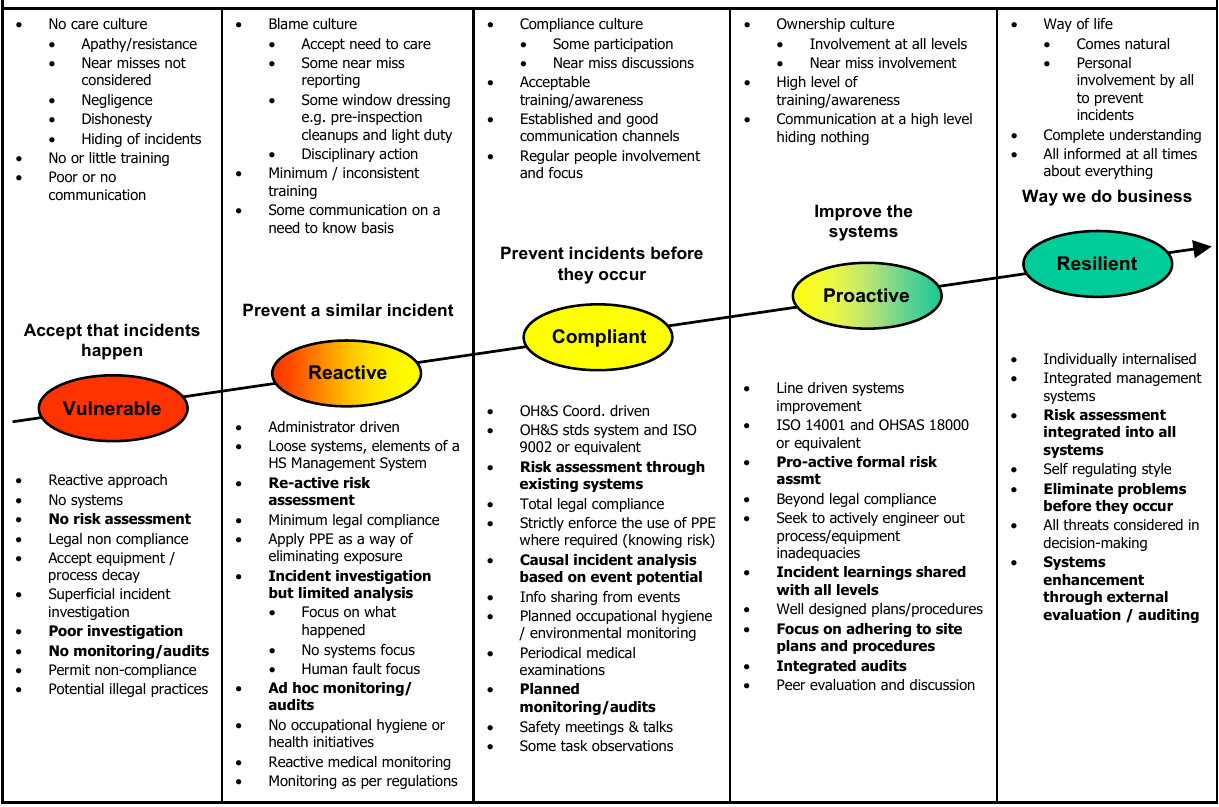
Figure 1. MIRM maturity chart